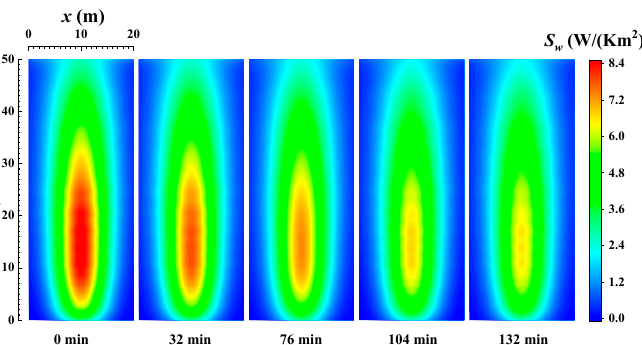
Figure 5. The distribution of the local REG rate on the wall when burning bituminous coal (Illinois #6).